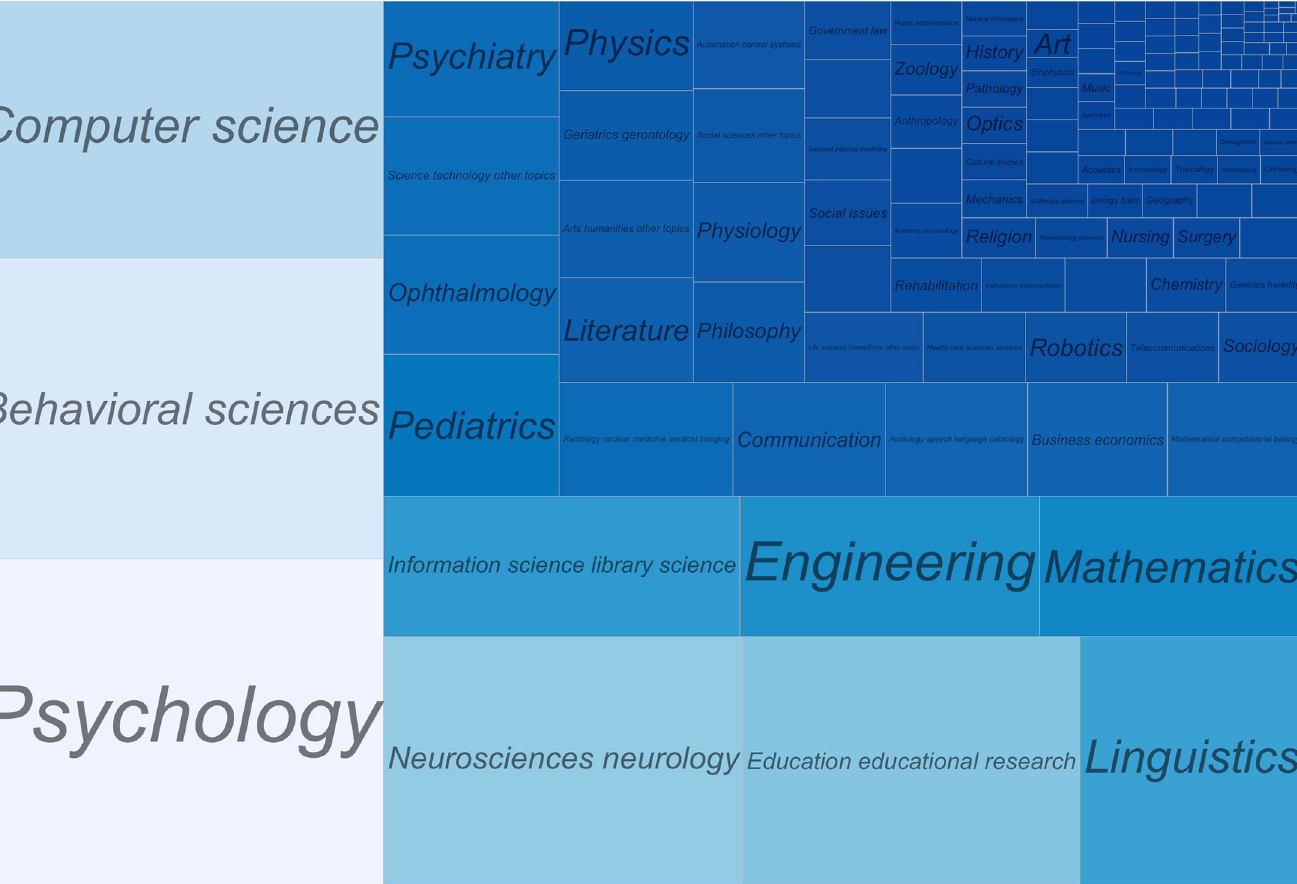
PLOS ONE | https://doi.org/10.1371/journal.pone.0232133 June 22,